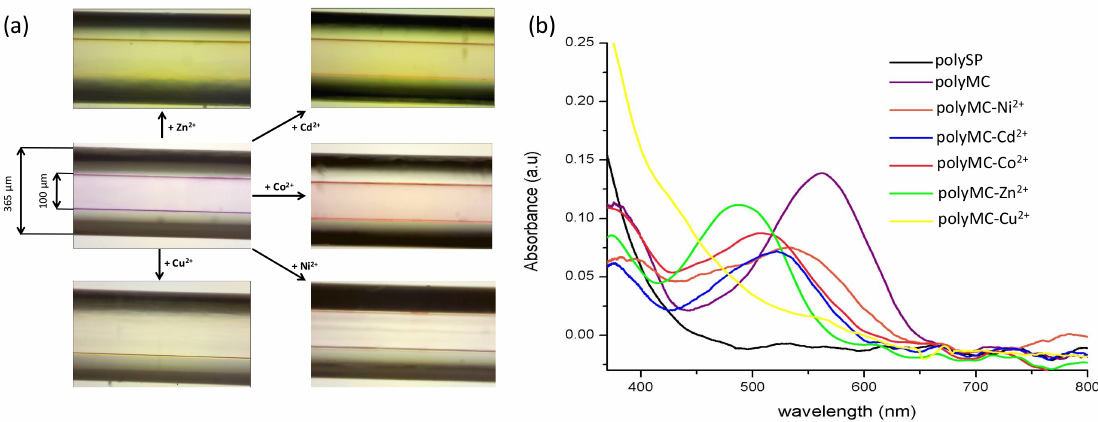
Figure 5. Images ( a ) and absorption spectra ( b ) of the coated micro-capillaries when solutions of different metal ions in ACN (10 − 3 M) are passed through the micro-capillary after irradiation for 1 min with UV light.